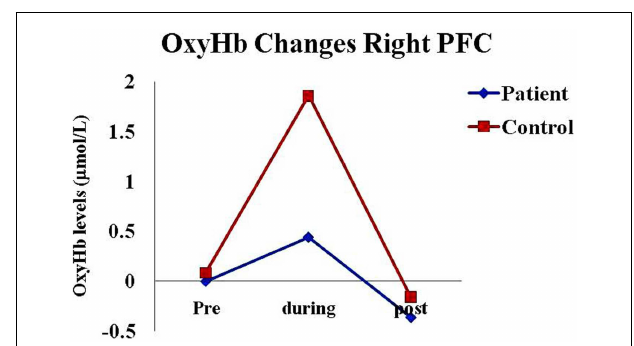
FIGURE 2 | Oxygenated hemoglobin changes in healthy subjects and schizophrenia patients in right pre-frontal cortex before (pre), during, and after (post) KB practice . Abbreviations: oxyHb, oxygenated hemoglobin; deoxyHb, deoxygenated hemoglobin; totalHb, total hemoglobin; PFC, pre-frontal cortex.